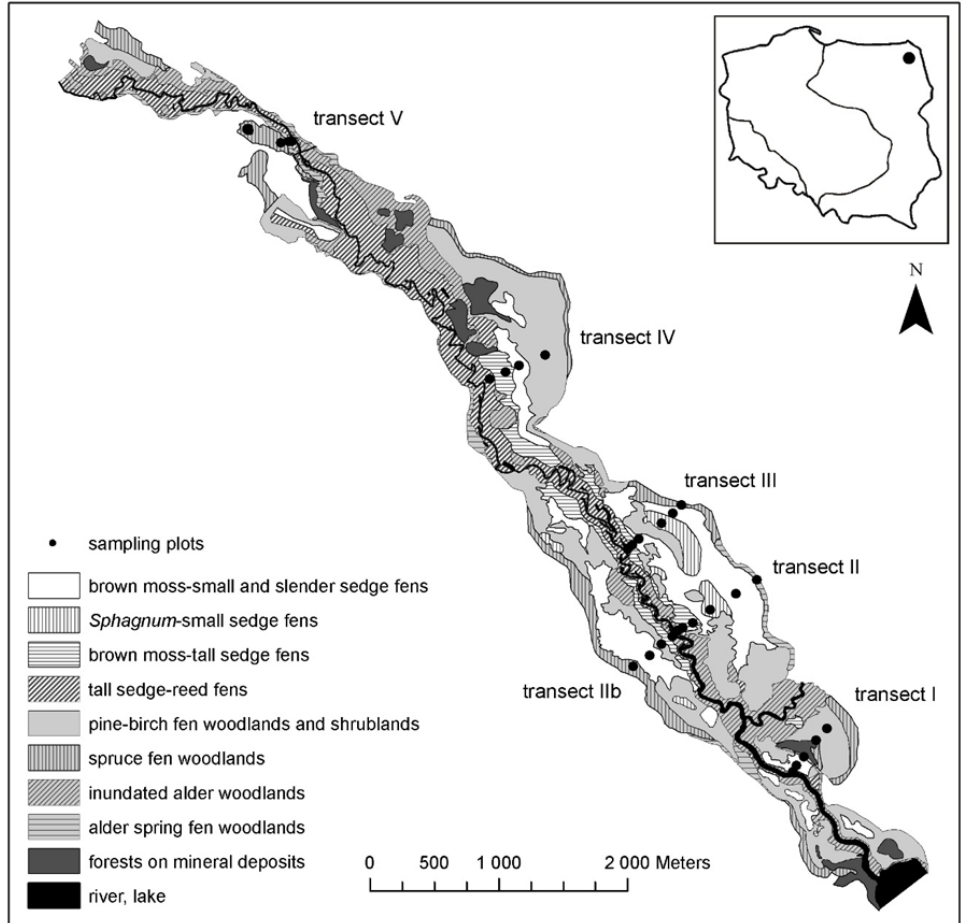
Figure 2. Location of the Rospuda valley and schematic vegetation map with sampling transects (after Jabłońska et al .